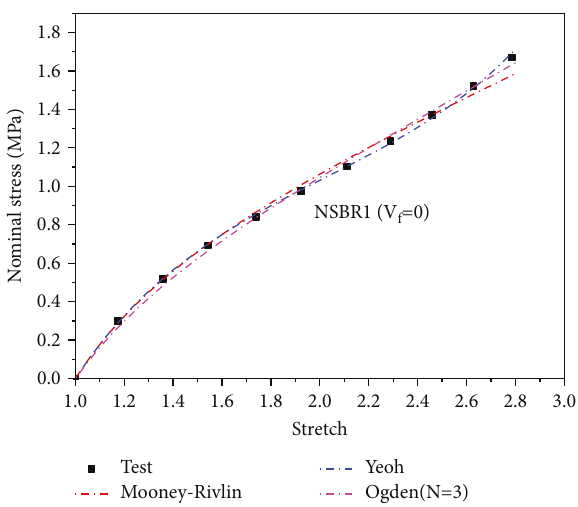
Figure 7: Fitting results of some constitutive models for tensile experimental data of NSBR1. Table 5: Material parameters of Yeoh models (NSBR1). Rubber